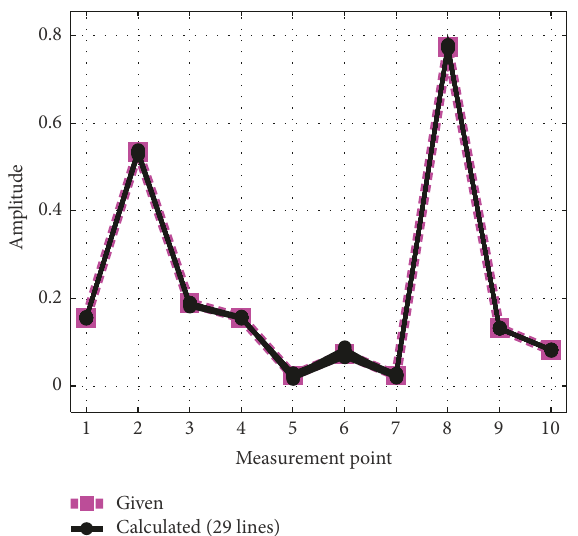
Figure 2: Mass distribution vectors calculated by the first seven